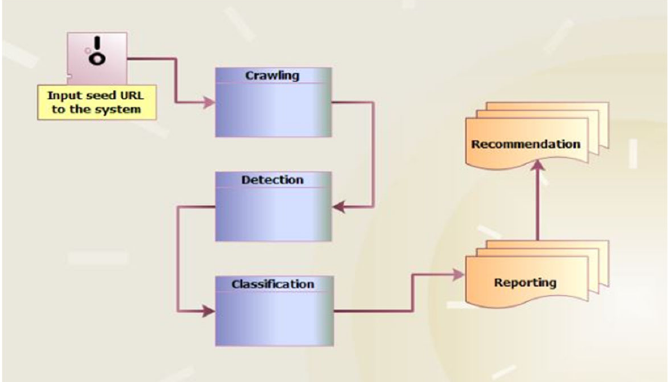
Fig. 2 . The Architecture of Proposed Malicious link